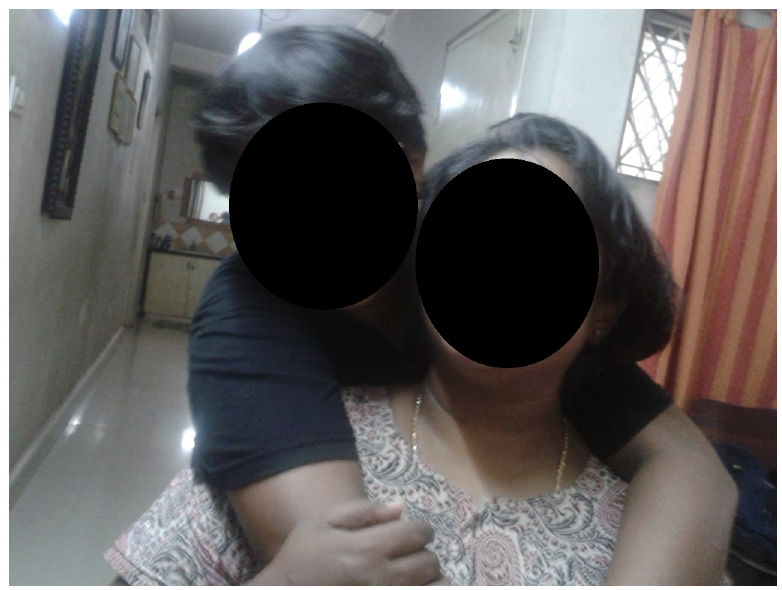
Fig 5. A moment with mom— © B1, male adolescent, 15 years.